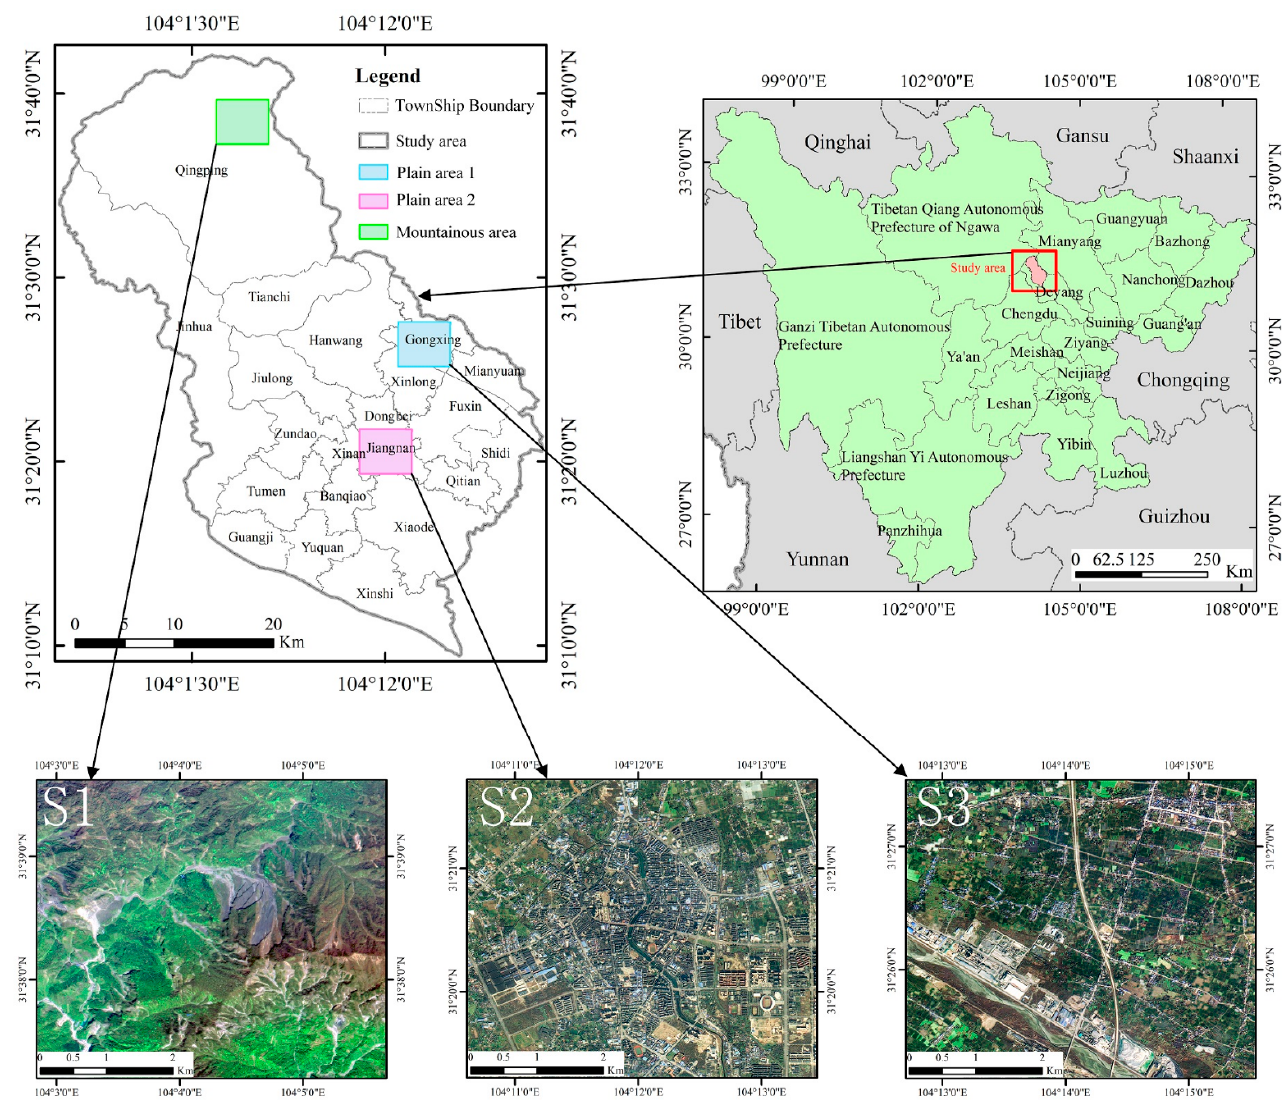
Figure 4. MZData geographical location and different typical terrain regions ( S1 represents mountainous area, S2 and S3 represent cities and villages in the plain area respectively).